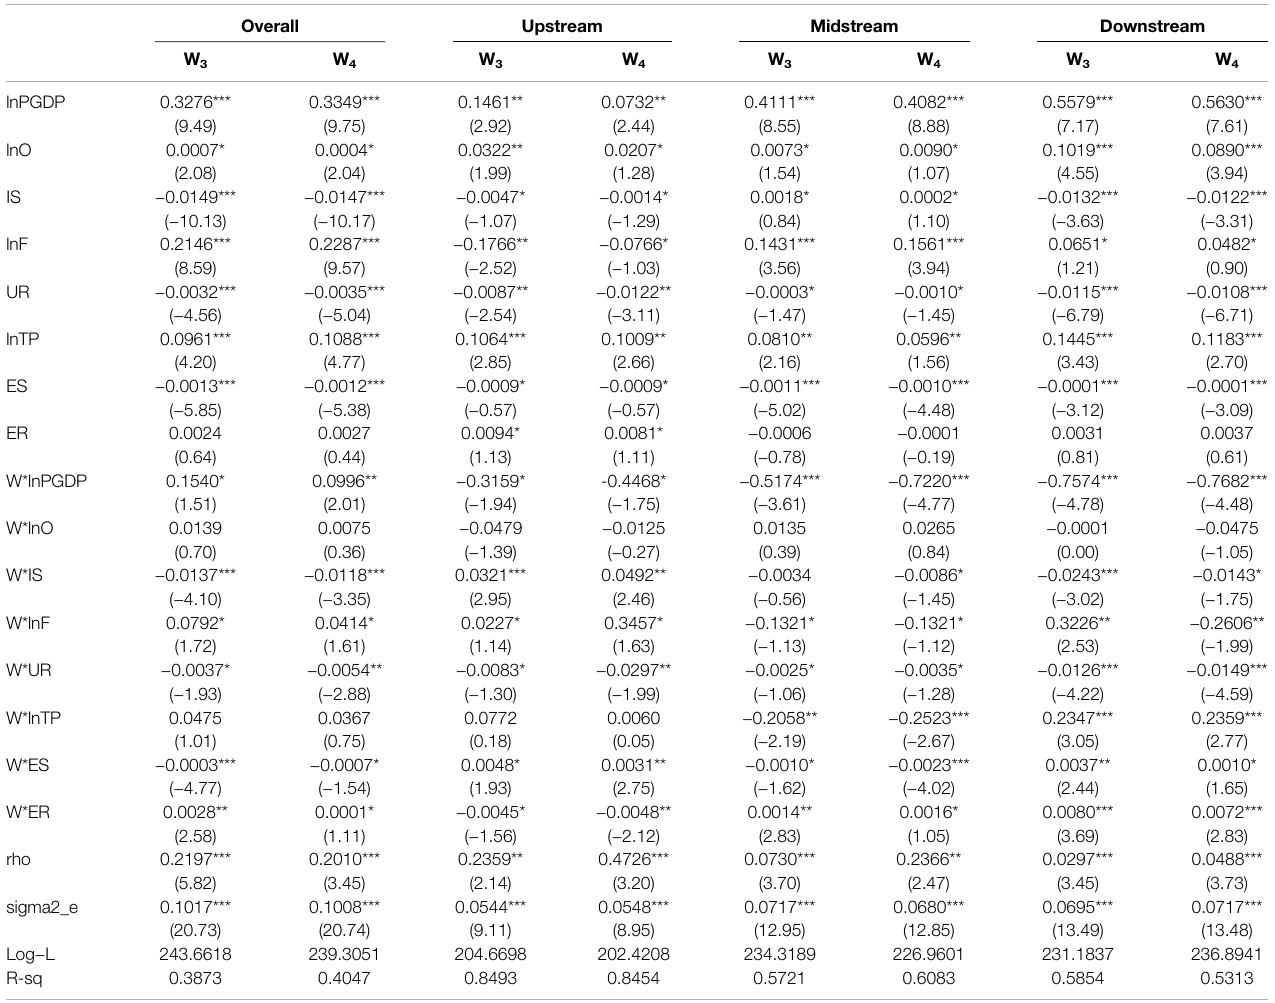
TABLE 6 | Spatial econometric model regression results.